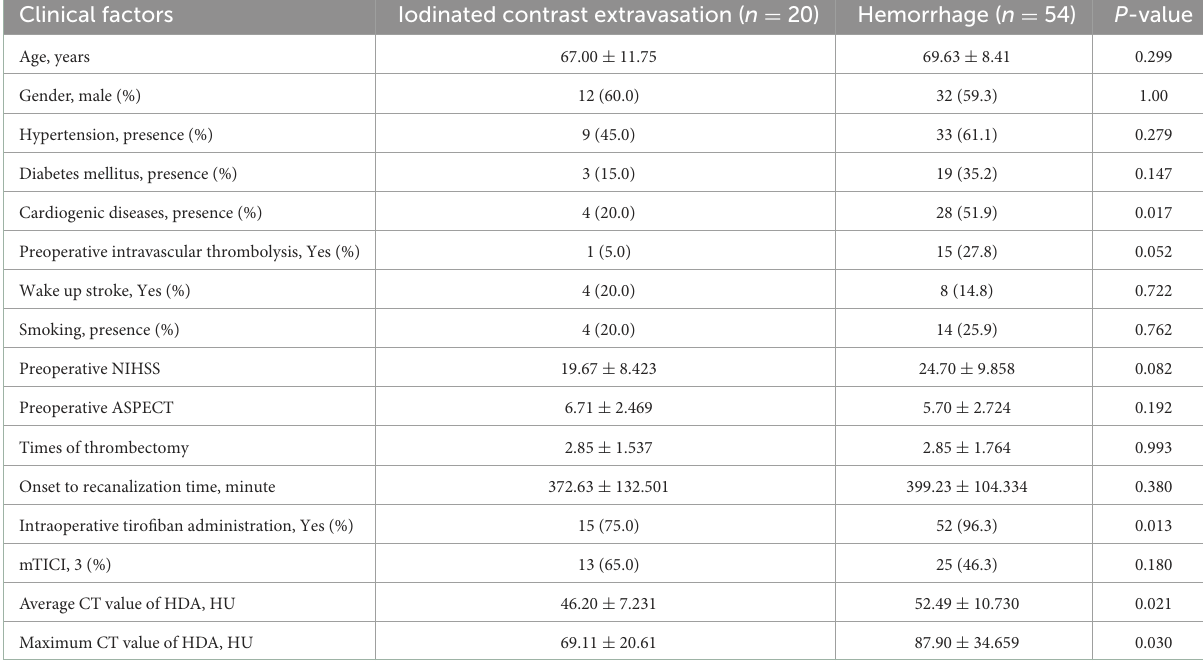
TABLE 1 Clinical factors of the primary cohort.